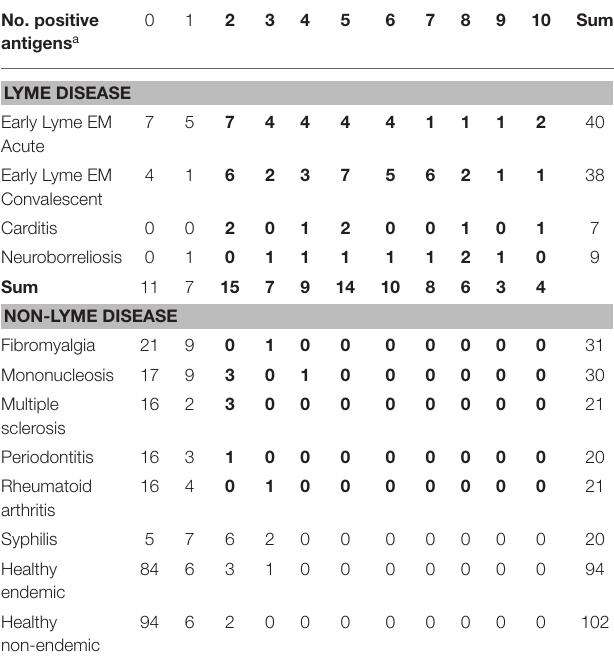
TABLE 4 | Number of antigens scored positive per individual serum sample by ROC analysis. No. positive antigens